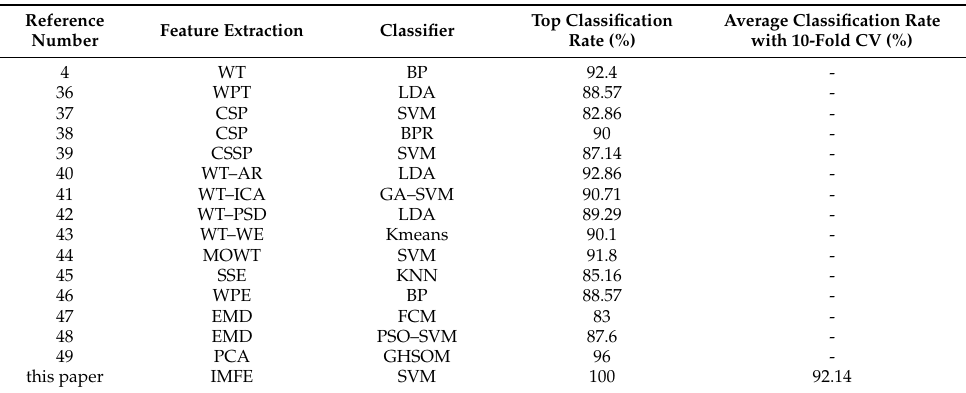
Table 4. Comparison with other recognition methods.